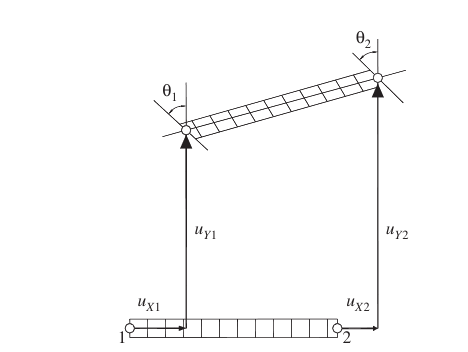
Figure 3 A two-node C 0 beam